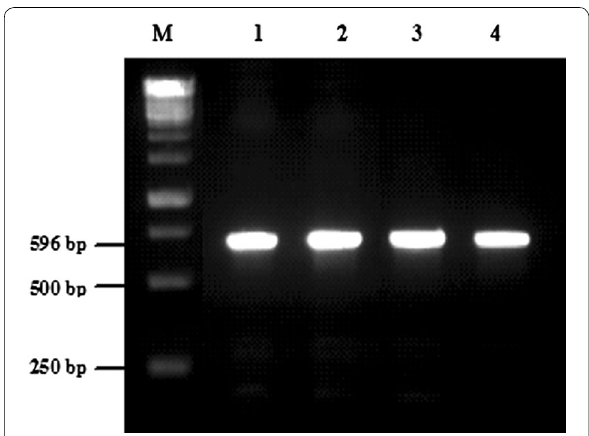
Fig. 2 Detection of plnEF sequences in Lactobacillus plantarum. Detection of plnEF sequences in 4 Lb. plantarum isolates. Lane M: molecular weight marker 1kb; Lane 1: M16; Lane 2: M17; Lane 3: M18; Lane 4: M19